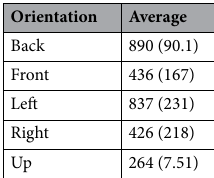
Table 2. Spectroradiometer fluence values for a 70 s cycle in each cabinet orientation. Values in brackets represent standard deviation.